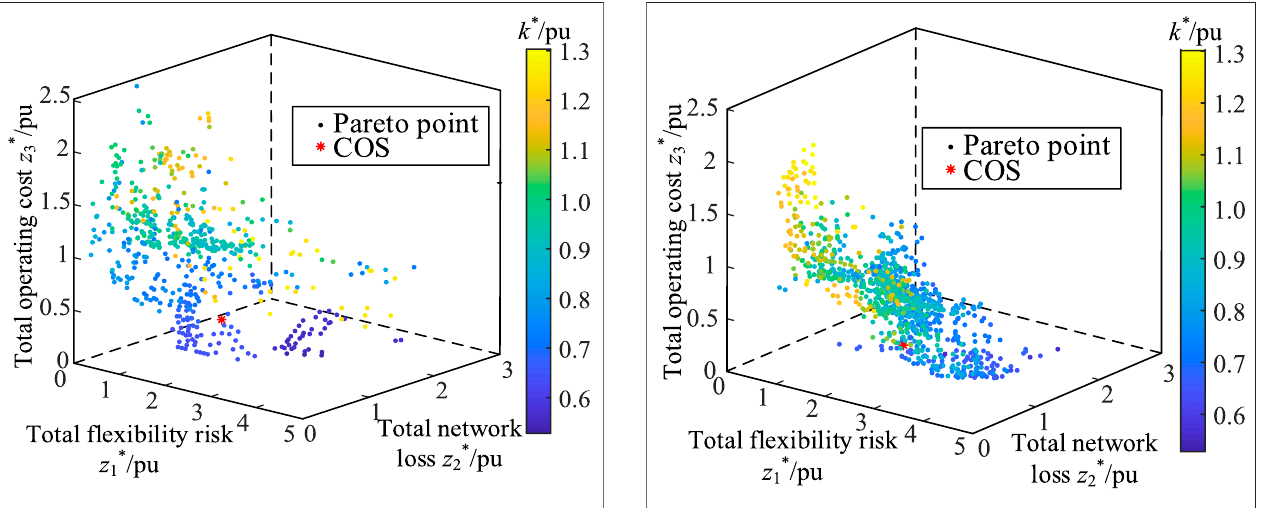
FIGURE 3 | Pareto frontier obtained by the curve-based ε -constraint